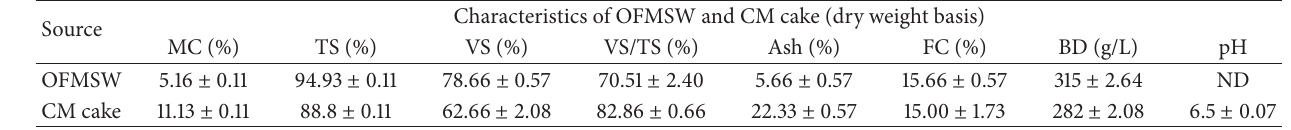
Table 2: Properties of feedstock and inoculum.